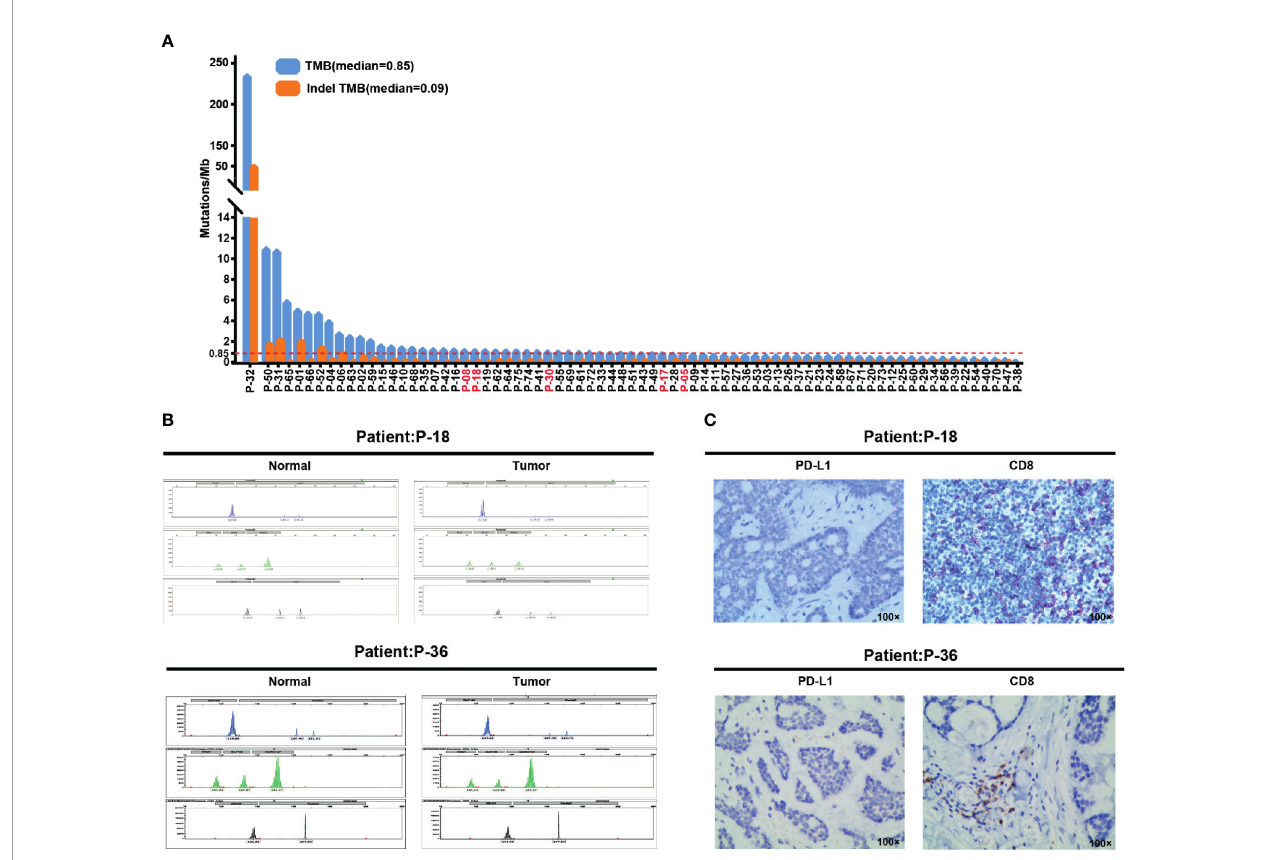
FIGURE 2 | Biomarkers for checkpoint inhibitor immunotherapy in ACC patients. (A) Distribution of TMB and indelTMB in 75 ACC samples. The red dotted line indicates the median value of TMB. Samples are arranged in order of decreasing TMB. (B) Case No.P-18 and No.P-36, microsatellite stable (MSS) according to conventional MSI- polymerase chain reaction (PCR) test. (C) Representative images for PD-L1 and CD8 immunohistochemical staining from case No.P-18 and No. P-36 at 100× original magni fi